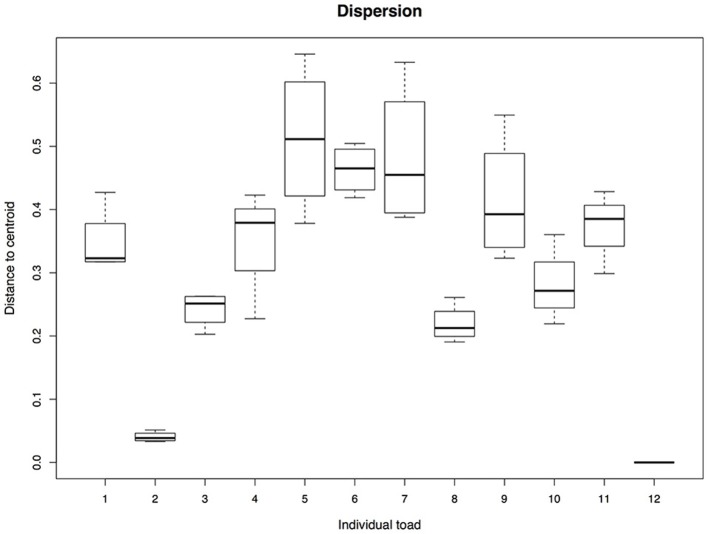
Dispersion among the plated bacterial communities from each individual toad. The analysis was conducted based on Bray-Curtis dissimilarity distances. The figure shows significant differences in dispersion among the individual toads. Boxplots represent the median, upper and lower quartile, and maximum and minimum values.